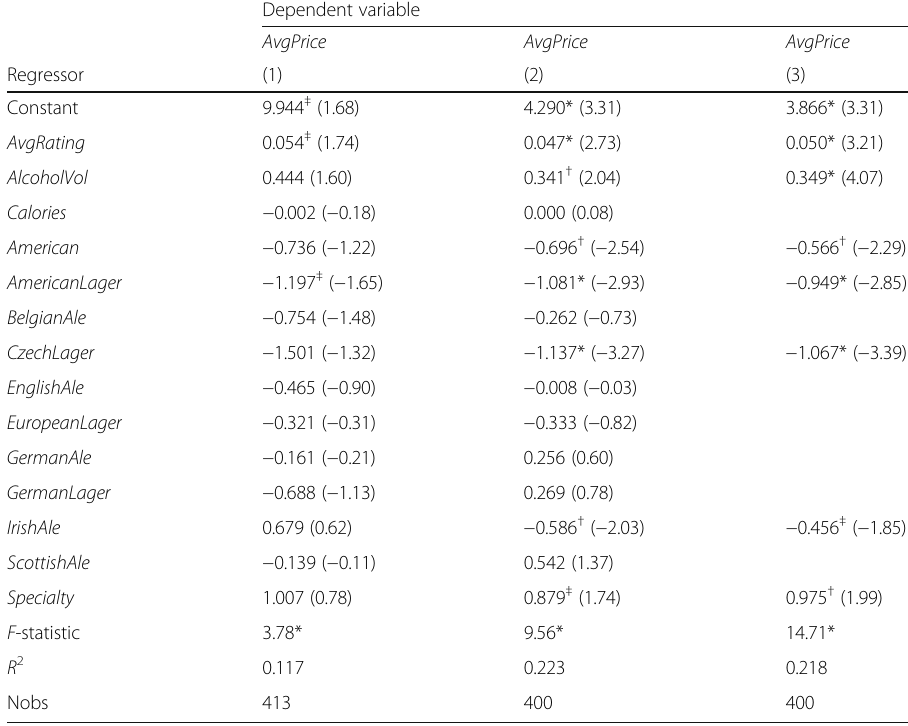
Table 2 Hedonic pricing regression